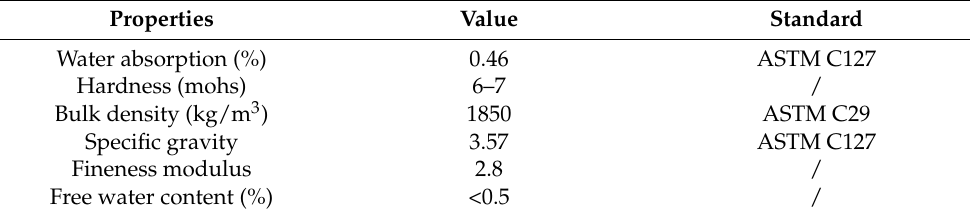
Table 5. Physical properties of copper slag.